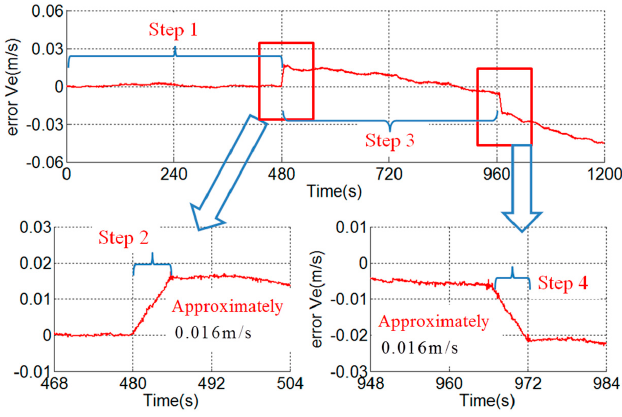
Figure 12. Stair error of east velocity.